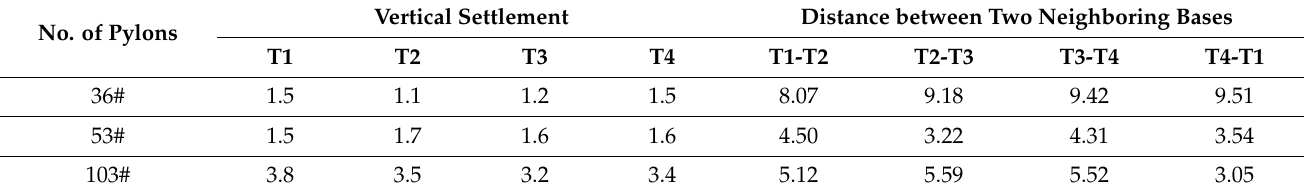
Table 5. The vertical settlement of four bases and distance between two neighboring bases of Pylon